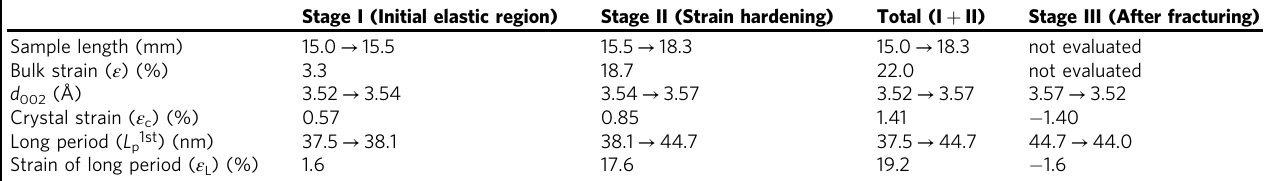
Table 4 Summary of the dimensional changes observed in the bulk sample, crystal unit cell, and hierarchical structure Stage I (Initial elastic region) Stage II (Strain hardening) Total (I + II) Stage III (After